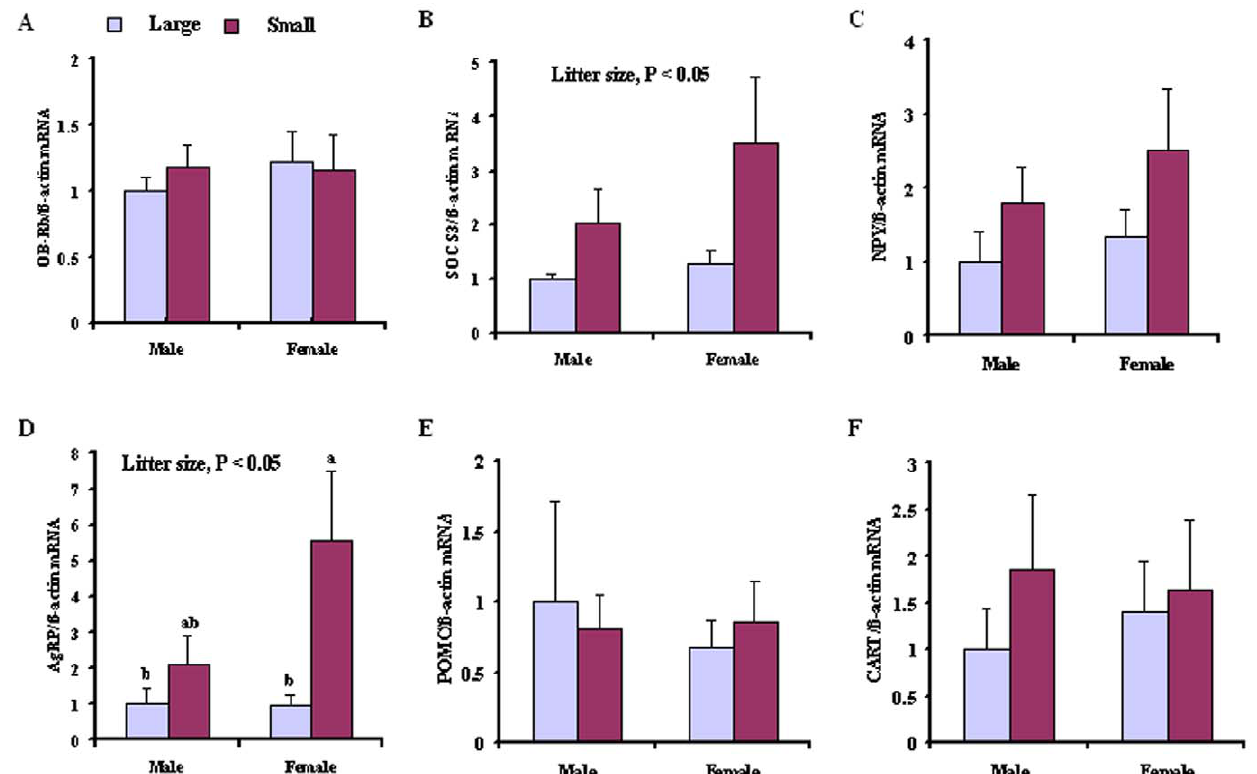
Figure 4. Hypothalamic OB-Rb (A), SOCS3 (B), NPY (C), AgRP (D), POMC (E) and CART (F) mRNA expression in adult male and female voles from large and small litters. Values are presented as mean 6 SE. Group differences are expressed as P , 0.05, and bars with different letters differed significantly from each other. Ob-Rb, leptin receptor; SOCS3, suppressor of cytokine signaling 3; NPY, neuropeptide Y; AgRP, agouti-related peptide; POMC, pro-opiomelanocortin; CART; cocaine- and amphetamine-regulated transcript.